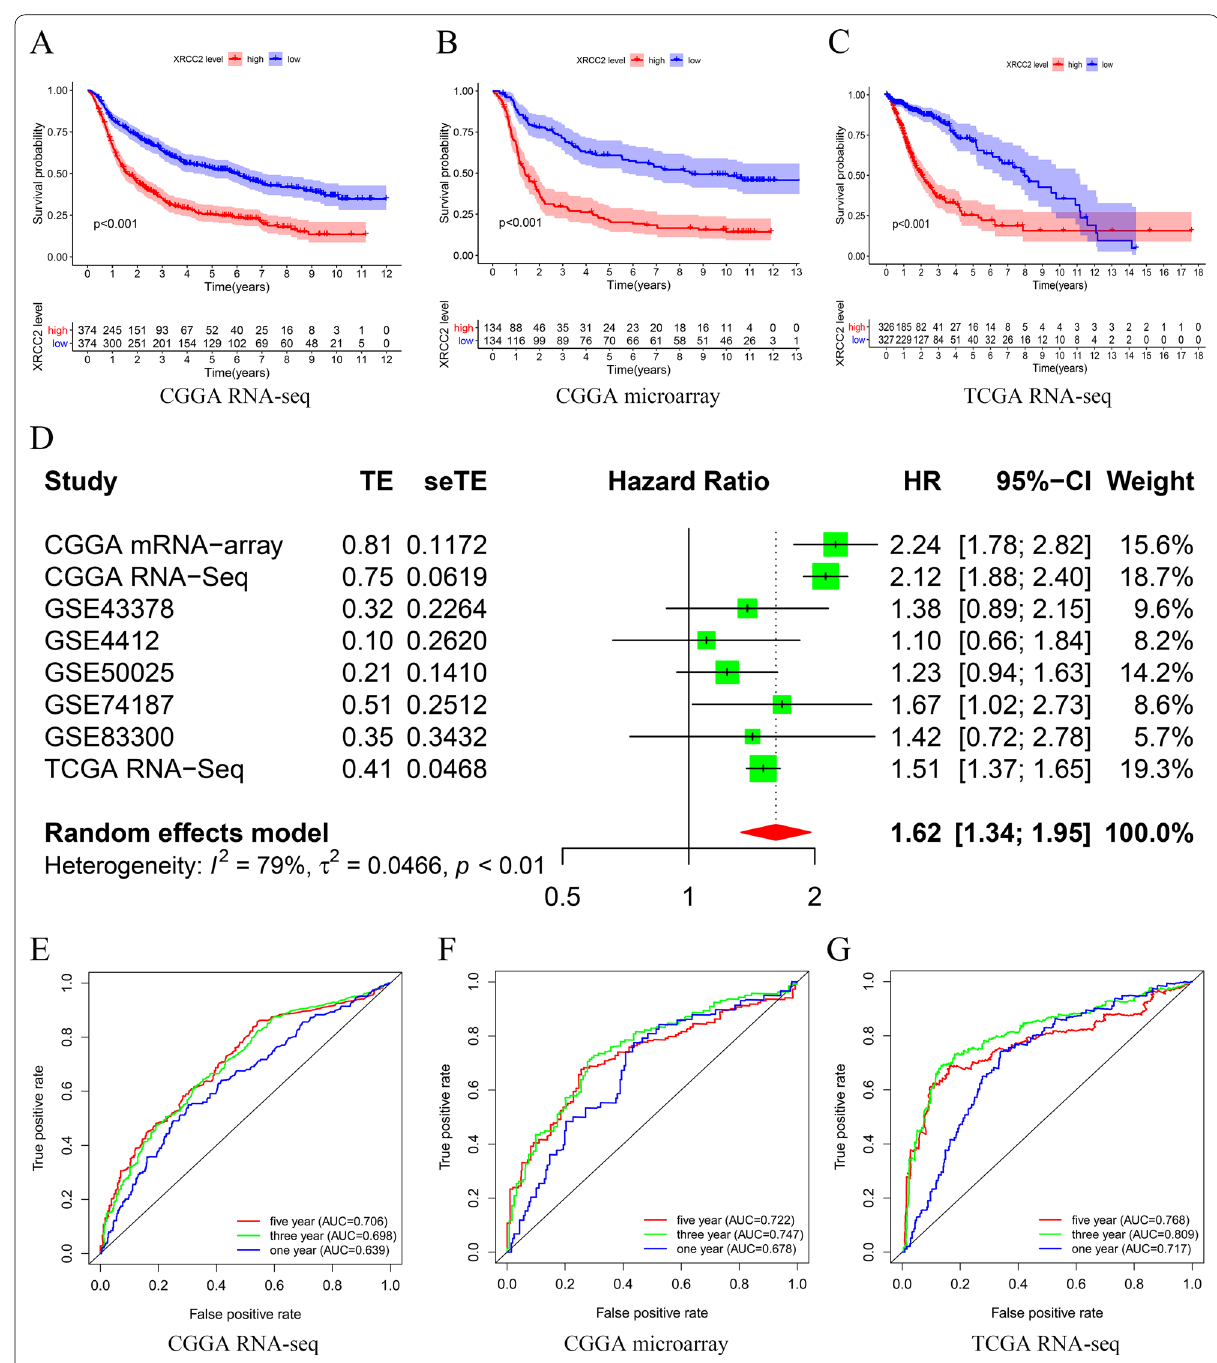
Fig. 2 Overexpression of XRCC2 predicts poor prognosis. A – C Kaplan–Meier survival curves based on CGGA RNA-seq, CGGA microarray, and TCGA RNA-seq, respectively; D Forest plot of high XRCC2 expression with better overall survival in glioma patients from eight datasets; E – G : ROC curves based on CGGA RNA-seq, CGGA microarray, and TCGA RNA-seq, respectively. CGGA Chinese Glioma Genome Atlas, TCGA The Cancer Genome Atlas, ROC receiver operating